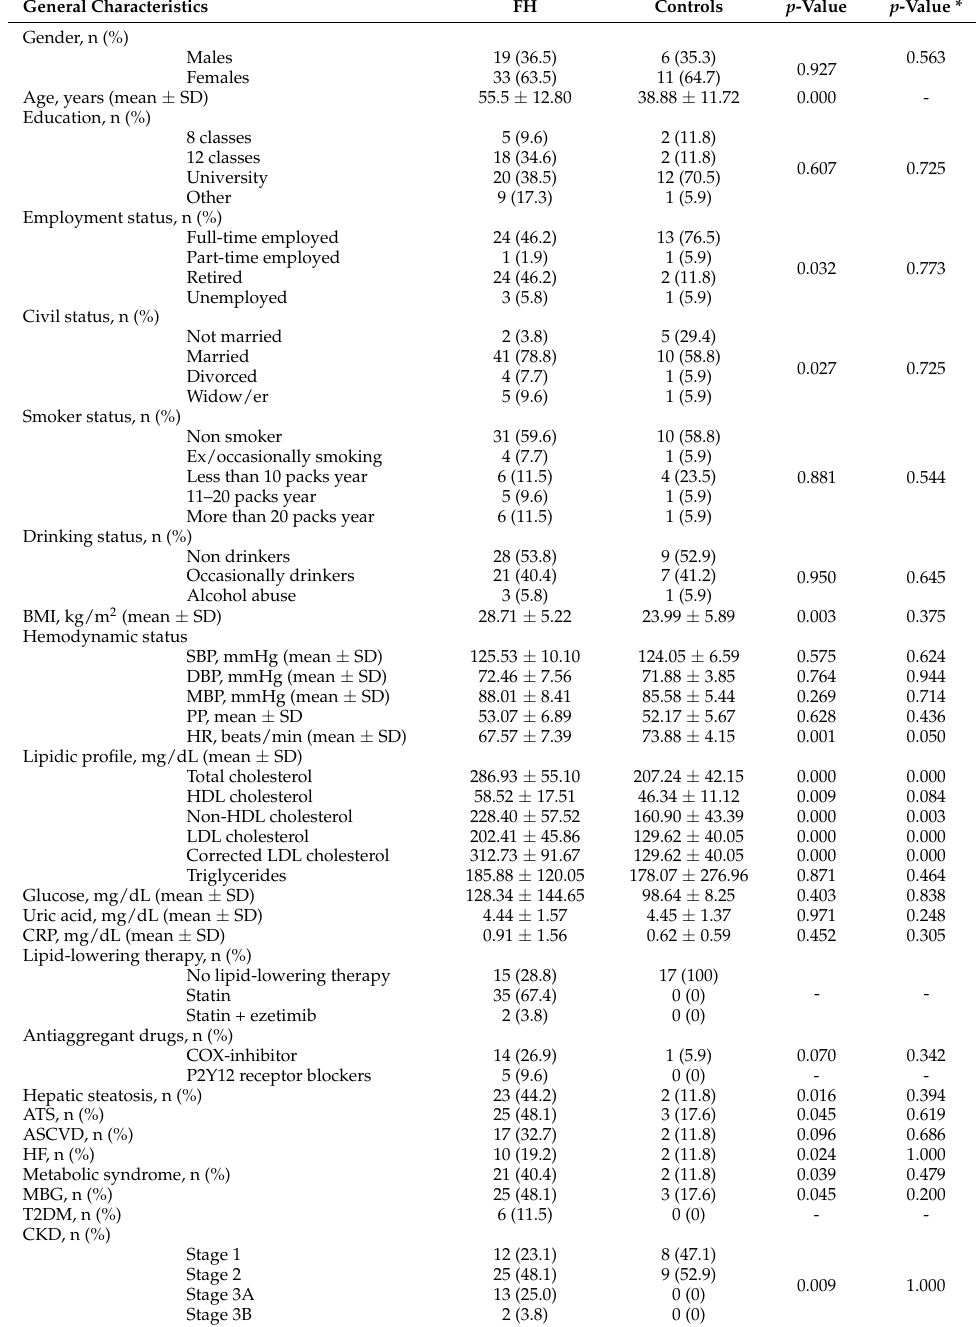
Table 1. General characteristics of the studied